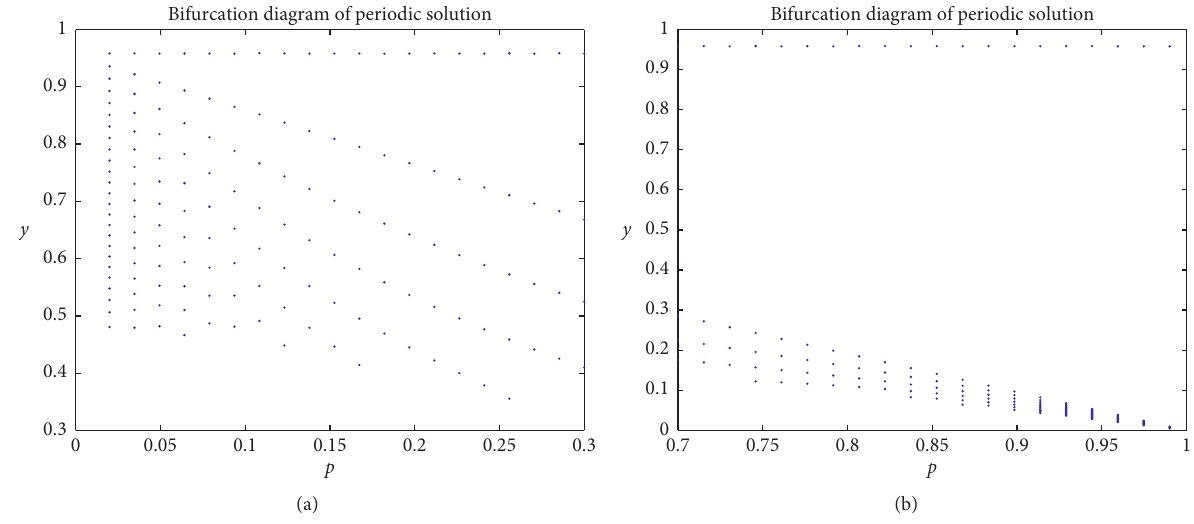
Figure 17: Bifurcation diagrams of system (12) with respect to p for p ∈ (0, 0.3] and p ∈ [0.7,